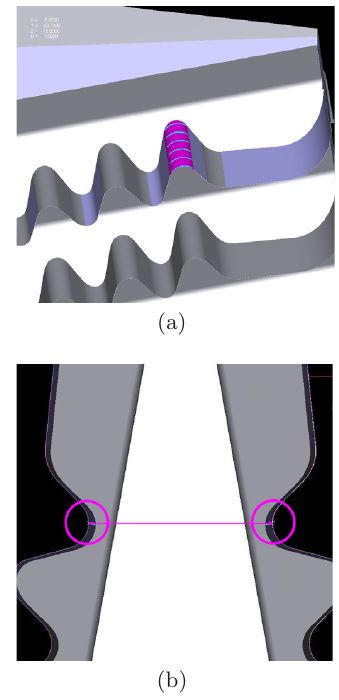
Fig. 3. Measured features of the broach: (a) inside radius, (b) distance of 2 opposite